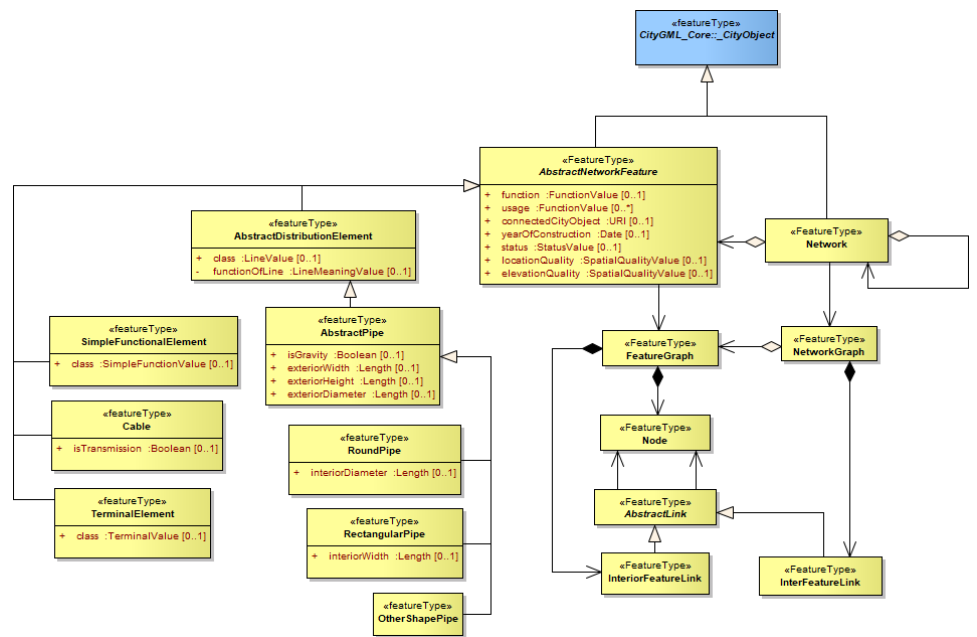
Figure 2. A simplified excerpt of the Utility Network UML diagram. The Network and the AbstractNetworkFeature allow for the topographical representation of a network, while the FeatureGraph and NetworkGraph classes (and their components classes) take care of the topological one. Further classes for specific network features (e.g. cables, pipes, etc.) are derived from the